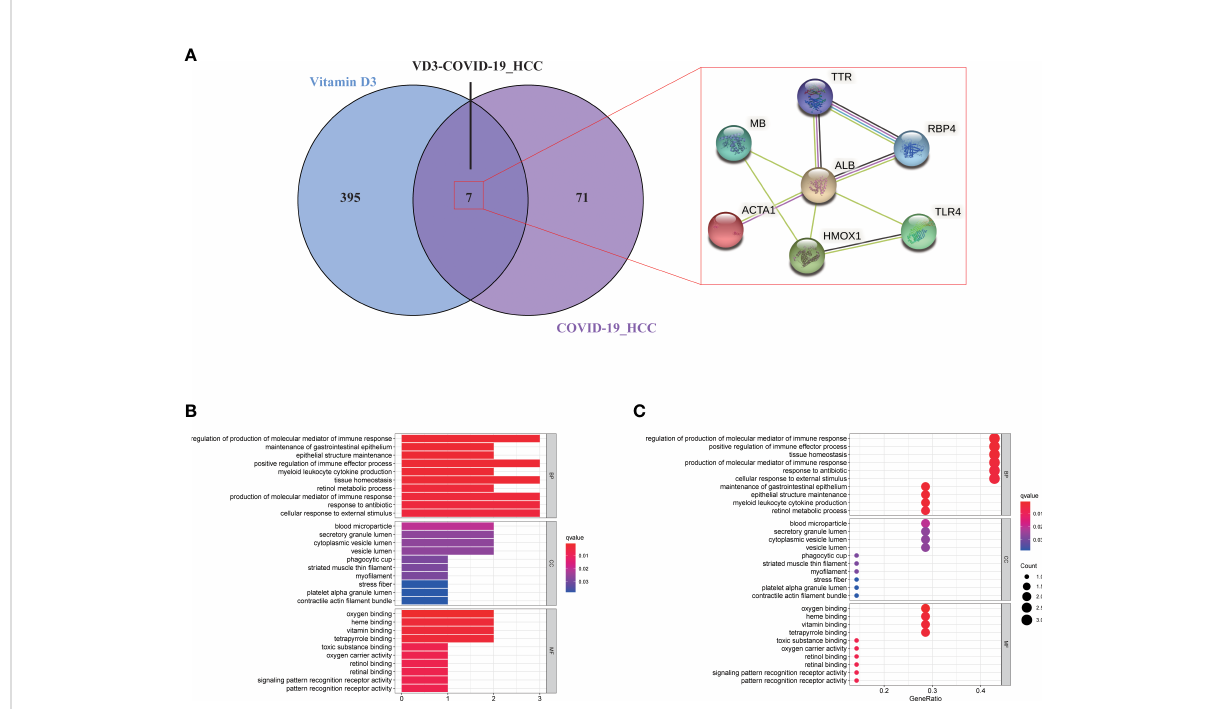
FIGURE 7 Functional enrichment analysis of vitamin D against COVID-19/HCC intersecting genes. (A) Venn diagram of vitamin D associated targets and COVID-19/HCC genes. (B) Bar plot and (C) bubble plot showing the results of GO enrichment analysis of vitamin D against COVID-19/HCC intersecting